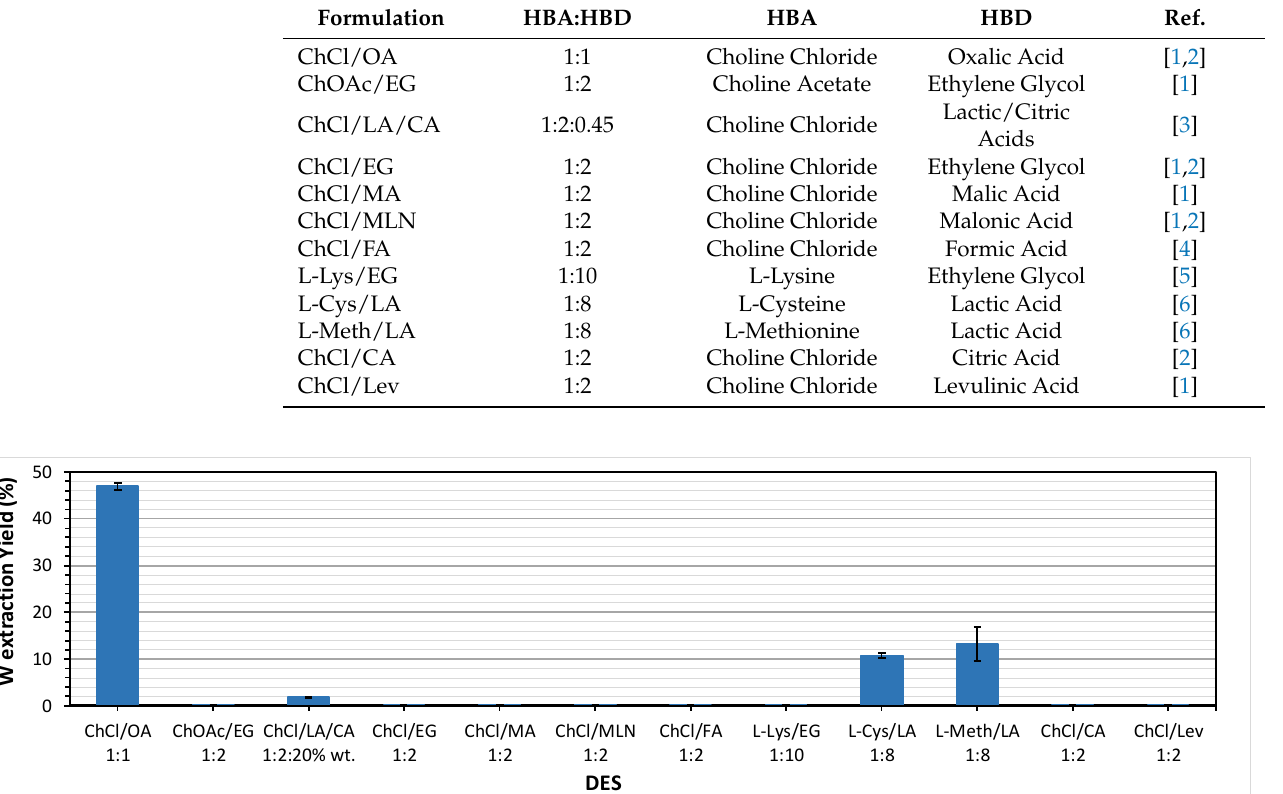
Table 1. Relation of DES used in the screening. HBA = Hydrogen bond acceptor, HBD = Hydrogen bond donor.